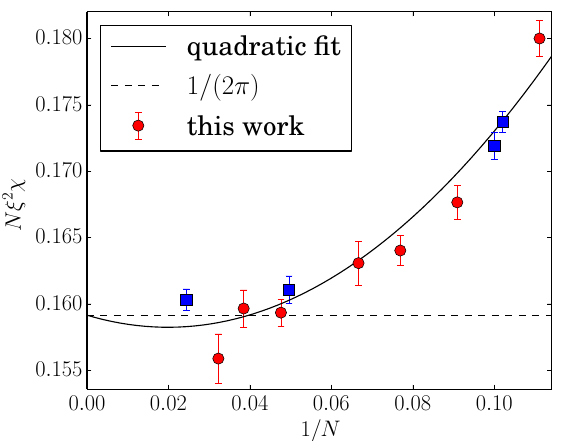
Figure 7 . Large- N behavior of Nξ 2 χ . We report also the values obtained in refs. [19] and